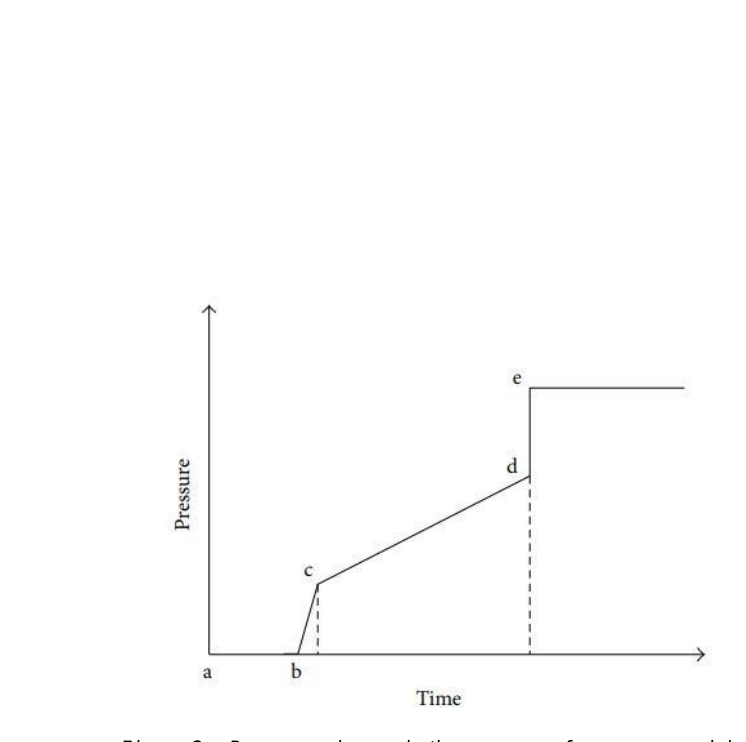
Figure 2 – Pressure change in the process of pressure modulation Рис. 2 – Изменение давления в процессе модуляции давления Слика 2 – Карактер промене притиска у процесу његове